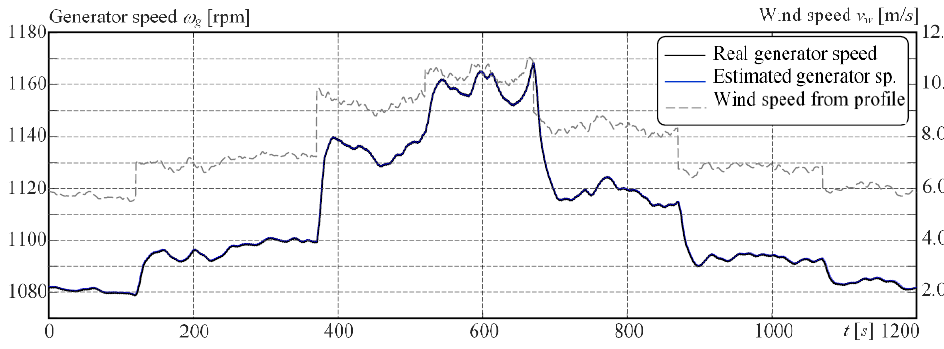
Figure 16. Time series of the generator speed.